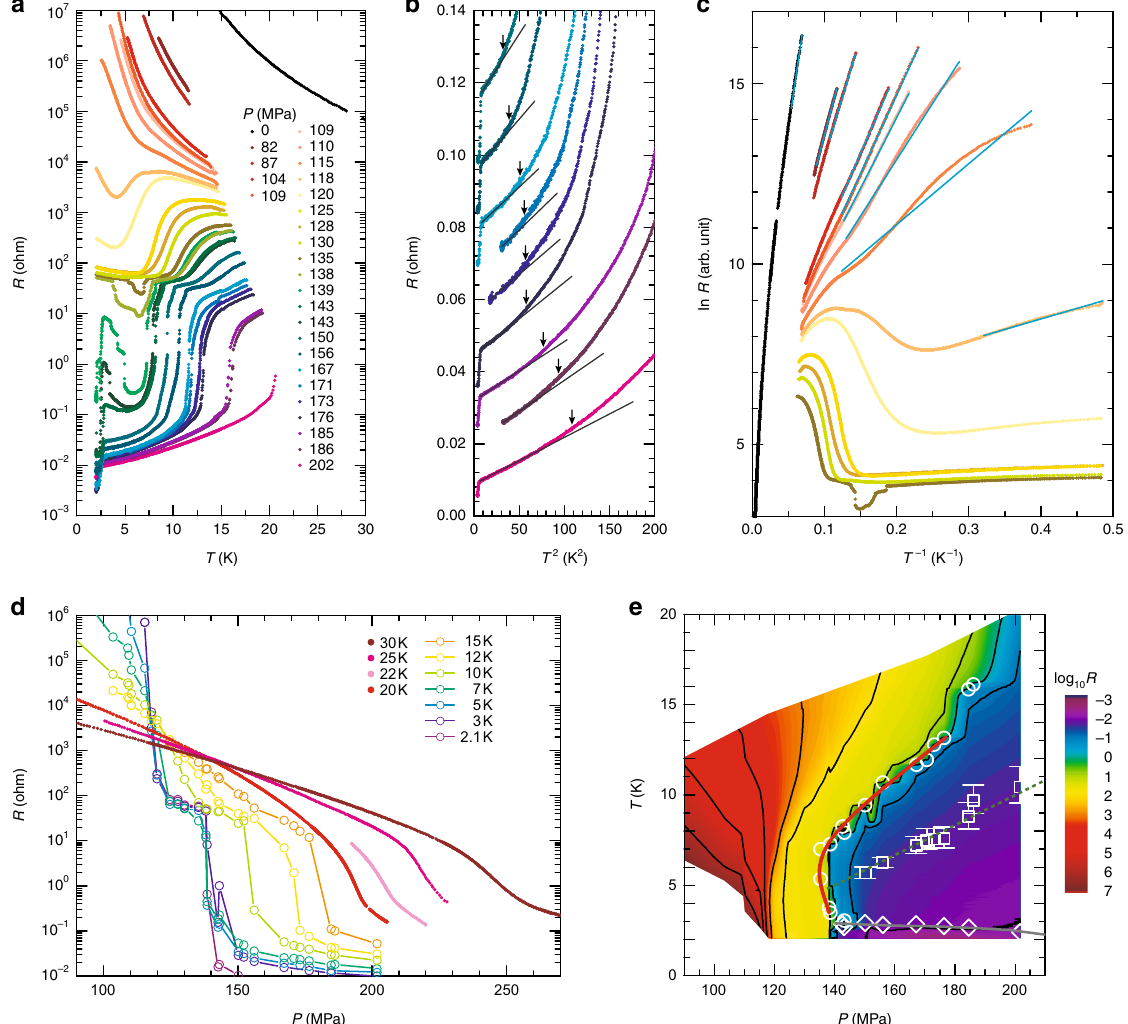
Fig. 2 Transport properties of κ -(ET) 2 Cu 2 (CN) 3 near the Mott transition. a Temperature dependence of the resistance of sample #1. The presented data are for low temperatures below the melting point of the helium pressure medium because the solidi fi cation is followed by a pressure drop, causing a spurious change in resistivity (see Supplementary Note 1 and Supplementary Fig. 2). b Resistance (offset by an interval of 0.01 ohm) vs. T 2 . The solid lines are fi ts of form R ( T ) = R 0 + AT 2 to the data. The coherence temperature T * at each pressure is indicated by arrows (see Fig. 1 for the de fi nition). c Arrhenius plot of resistance in the insulating phase. The cyan solid lines are the fi ts of form ln R ( T ) = Δ /2 × T − 1 +const. to the data at low temperatures (see Supplementary Note 6 and Supplementary Fig. 9 for details). d Pressure dependencies of the resistances of samples #1 ( T ≤ 22 K) and #2 ( T ≥ 25 K) at fi xed temperatures. The resistance of sample #2 was multiplied by 1.5 for comparison. The measurements at T above 20 K, where the helium pressure medium is in a liquid state, were performed in isothermal pressure sweeps. e Contour plot of the logarithmic resistance of sample #1 in the P – T plane. The black lines are contour lines. The open circles (Mott transition points), squares ( T * ) and diamonds ( T sc ) are reproduced from Fig.